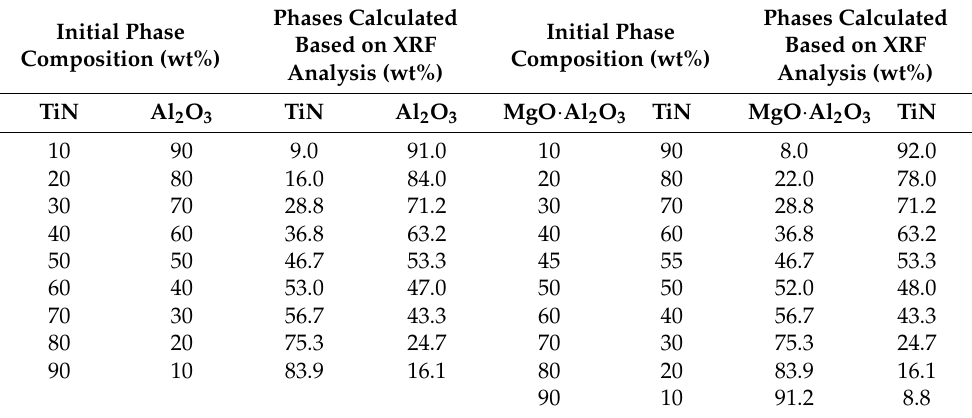
Table 2. Prepared sample composition and XRF analyses obtained from binary phases of TiN–Al 2 O 3 and